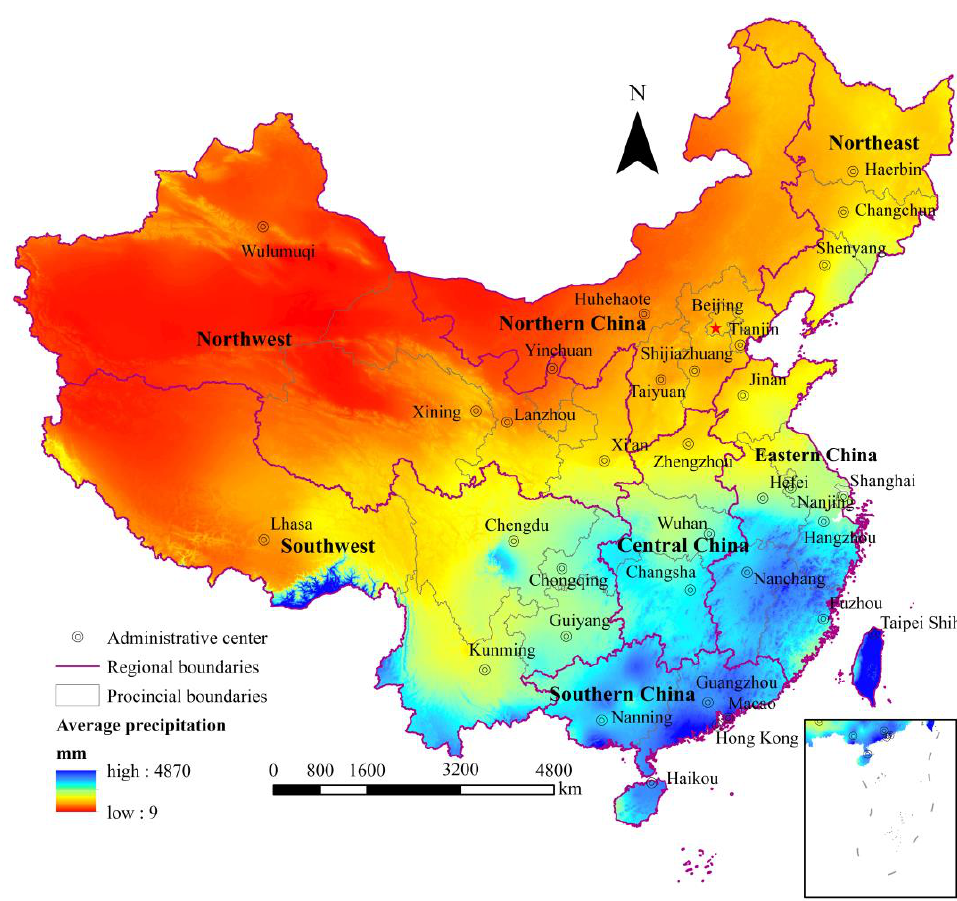
Figure 1. Schematic diagram of the average annual precipitation amounts in the study area .